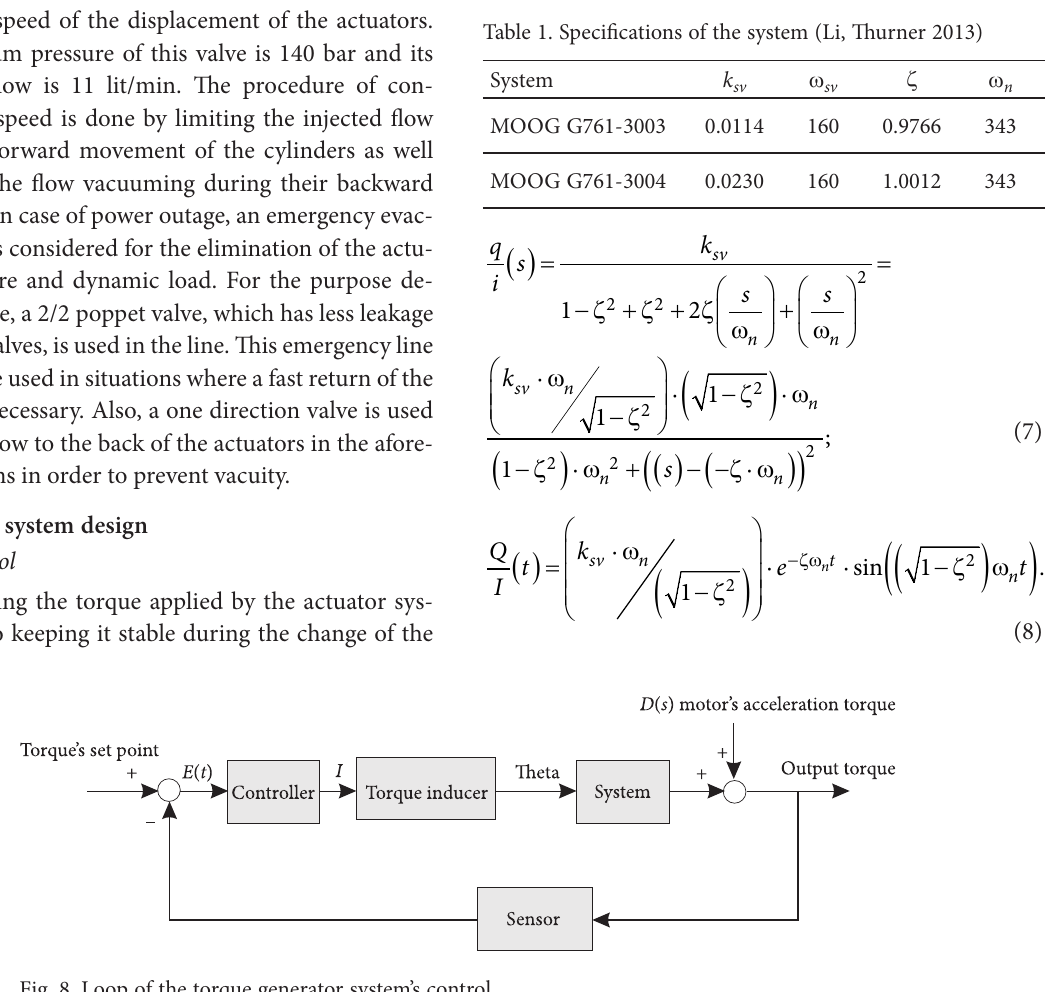
Fig. 8. Loop of the torque generator system’s